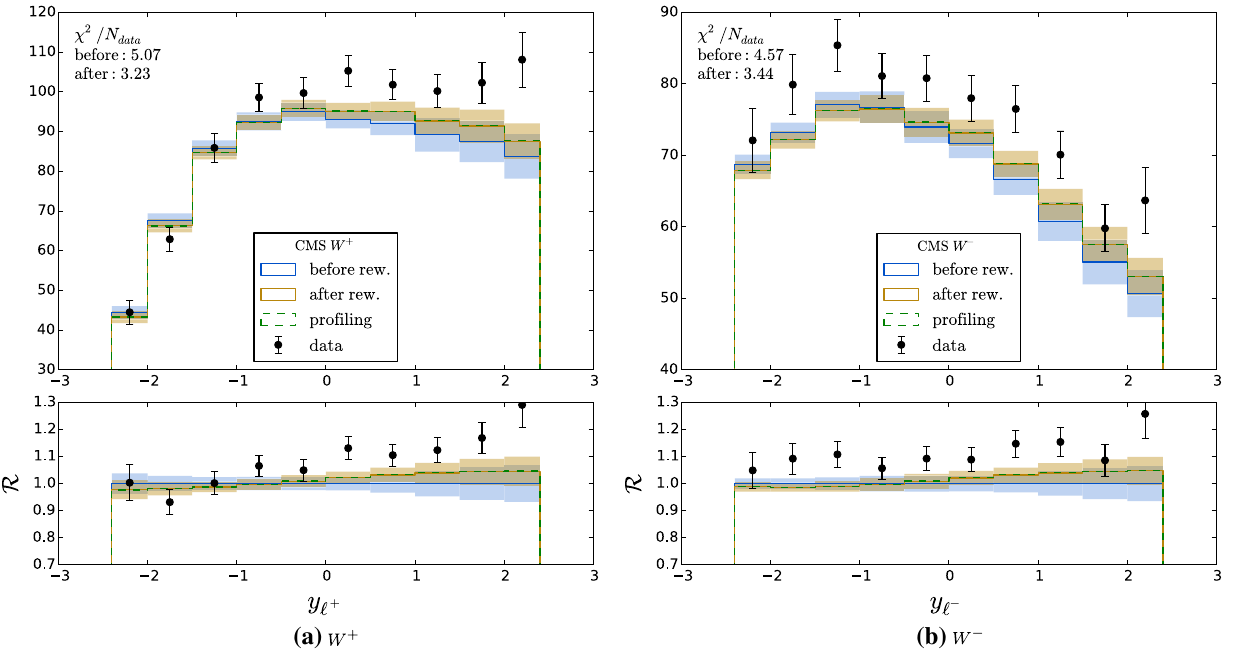
Fig. 18 Comparisonofdataandtheorybeforeandafterthereweightingprocedurefortherapiditydistributionsofchargedleptonsin W ± production measured by CMS